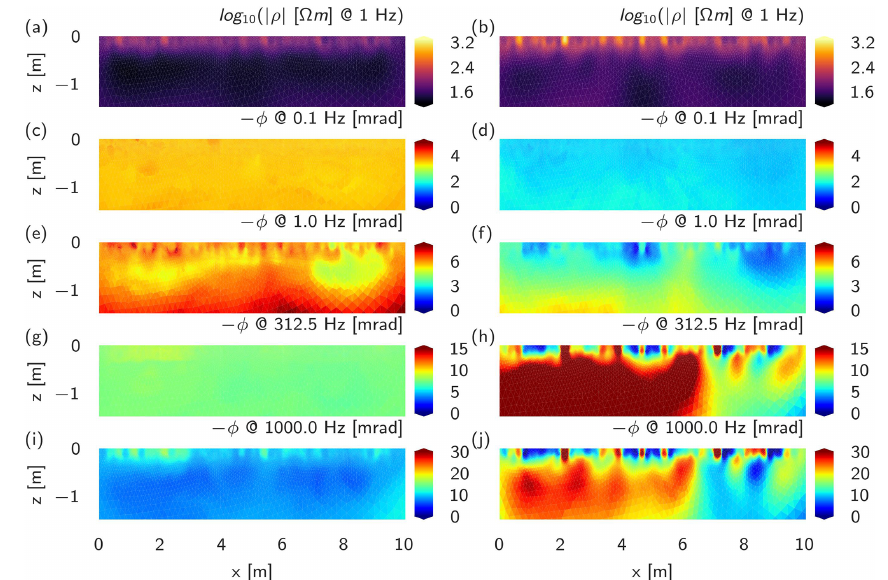
Figure 13. Temperature-corrected tomographic results for two time steps and selected frequencies. Left column: 1 May 2018. Right column: 1 August 2018. The inverted values are median values of all inversions in a 24h interval around the target time with rms values between 0.95 and 1.05. Note that the colour-bar limits vary for different frequencies.